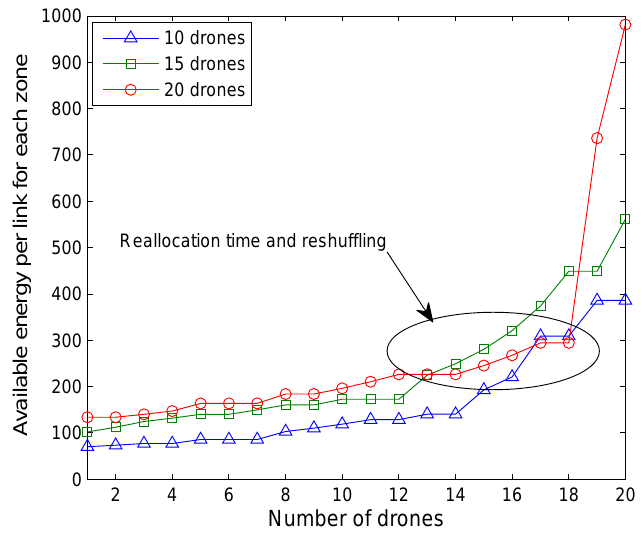
Figure 10. Available energy per link for each zone vs. number of